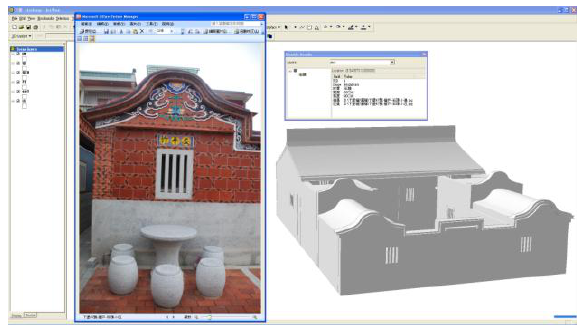
Figure 4. 3D GIS-based HBIM database